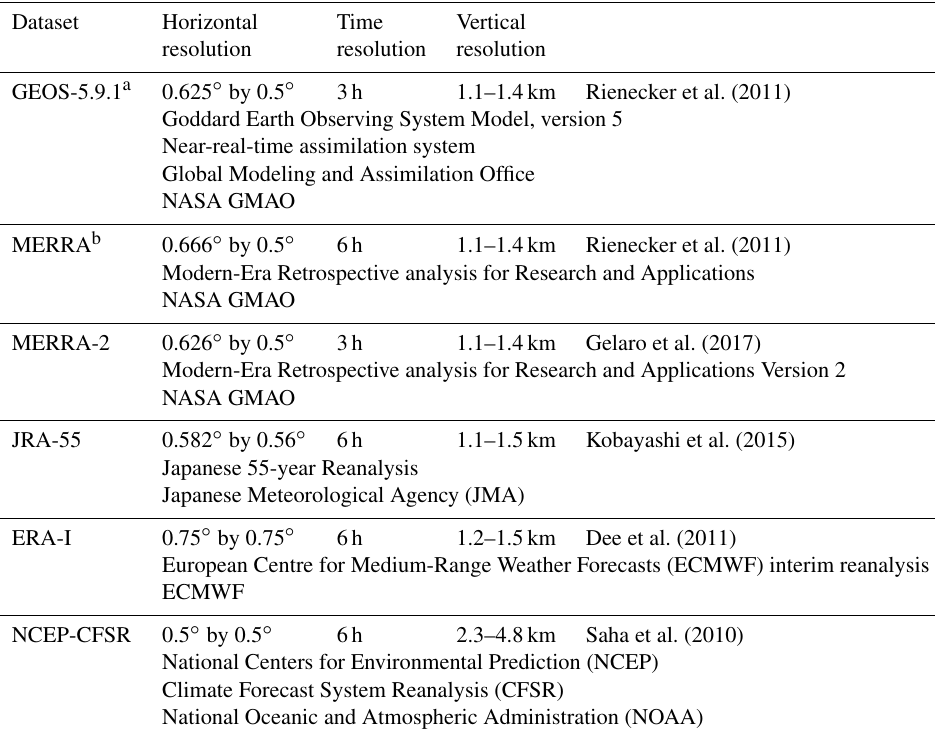
Table 1. Reanalysis temperature data. Details are valid for the 100–10hPa region and 2008–2013.